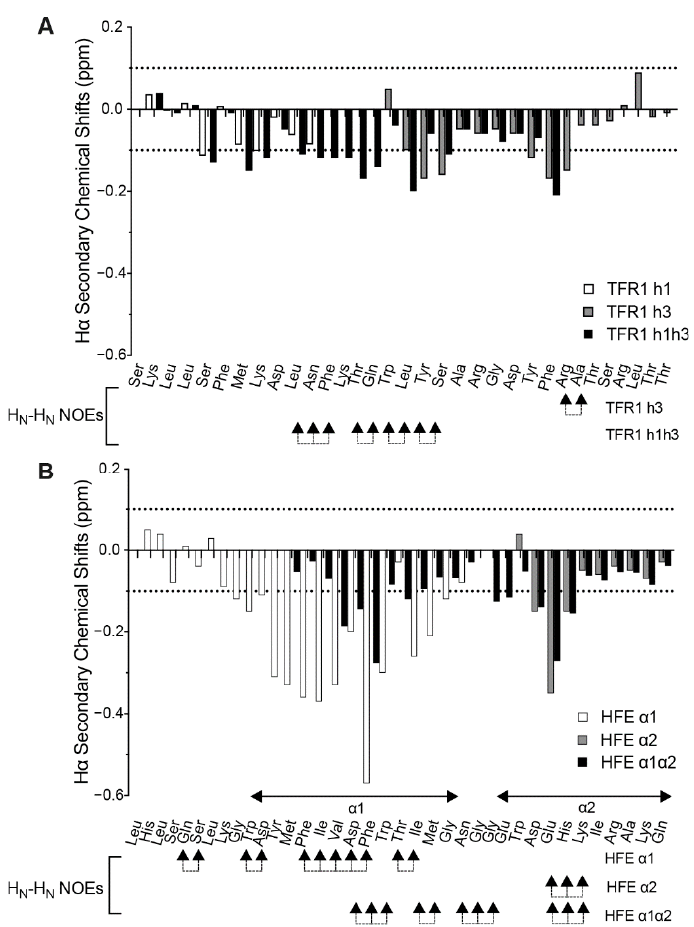
Figure 2. Comparison of the H α secondary chemical shifts for both series of target peptides. All 1 H NMR spectra were recorded at 298 K on a Bruker Avance 600 MHz spectrometer. Spectra were assigned using CCPNMR Analysis [22]. ( A ) TFR1-like series of target peptides: TFR1 h1, TFR1 h3, and TFR1 h1h3. ( B ) HFE-like series of peptides: HFE α 1, HFE α 2, and HFE α 1 α 2.